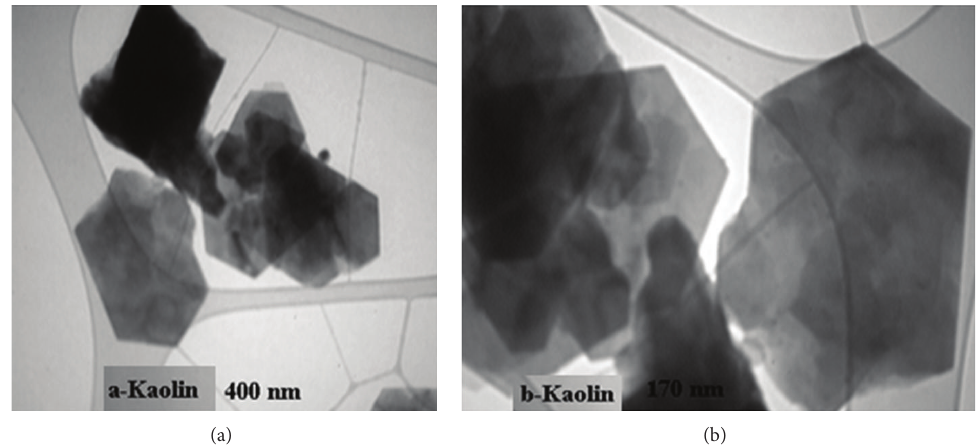
Figure 4: TEM images of (a) Kaolin 400 nm and (b) Kaolin 170